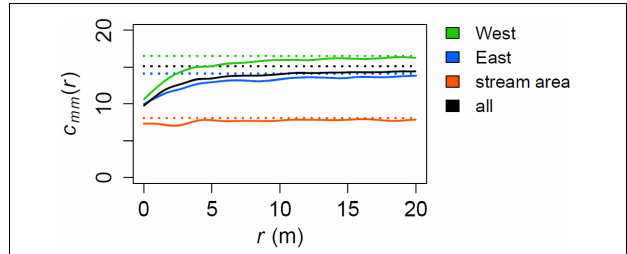
FIGURE 9 | Mark correlation functions c mm ( r ) for diameter of living trees in the subplots and for the whole study area with their expected values (dotted lines). Calculated with test function t ( m 1 , m 2 ) = ( m 1 + m 2 )/ 2. The function can be interpreted as the expected mean of the diameters of two trees separated by distance r . Note the differing expected values (mean diameters) between the